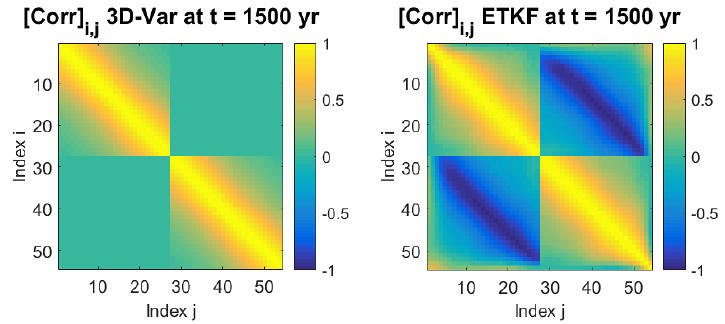
Figure 10. The background error covariance matrices used by the 3D-Var and ETKF methods to produce the analysis at time t = 1500